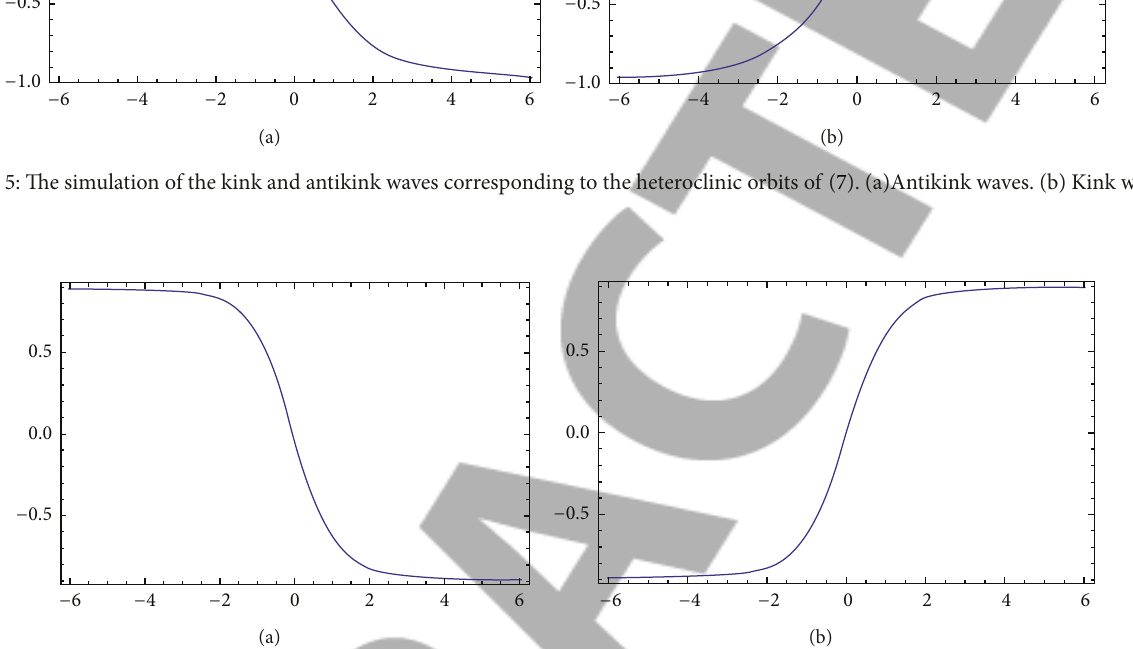
Figure 6: The simulation of the kink and antikink waves corresponding to the eye-figure loop of (7). (a) Antikink waves. (b) Kink waves.